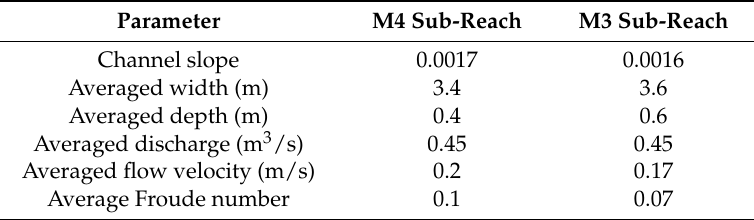
Table 1. Channel and flow characteristics in the study area based on the ADCP measurements at the moderate flow in 2014.